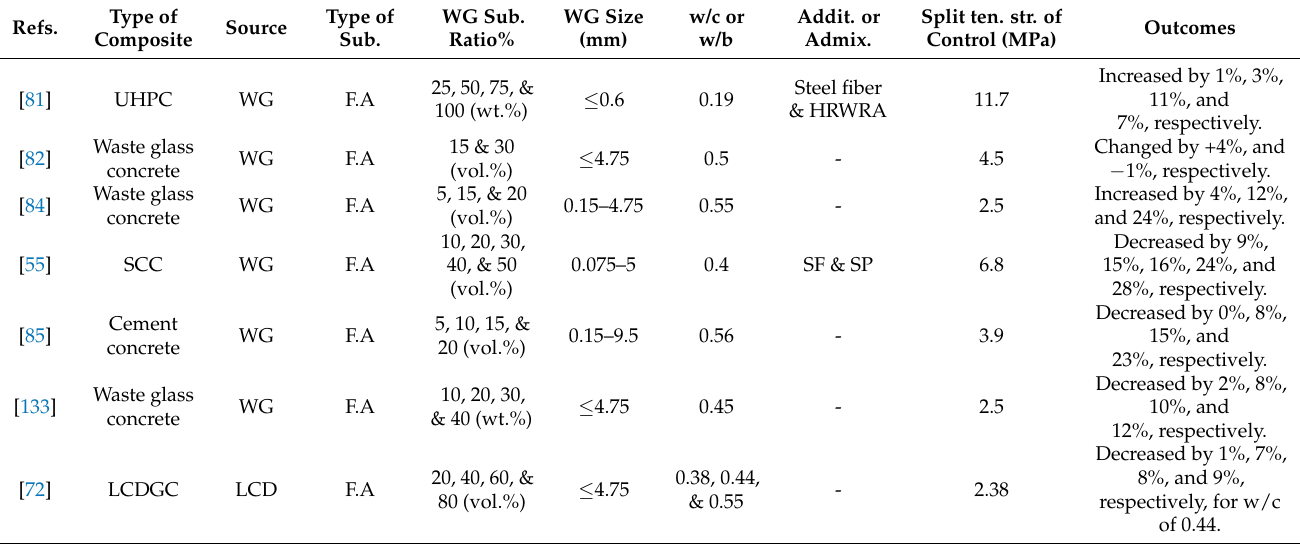
Table 7. Summary of the results of past studies on the splitting tensile strength of waste-glass